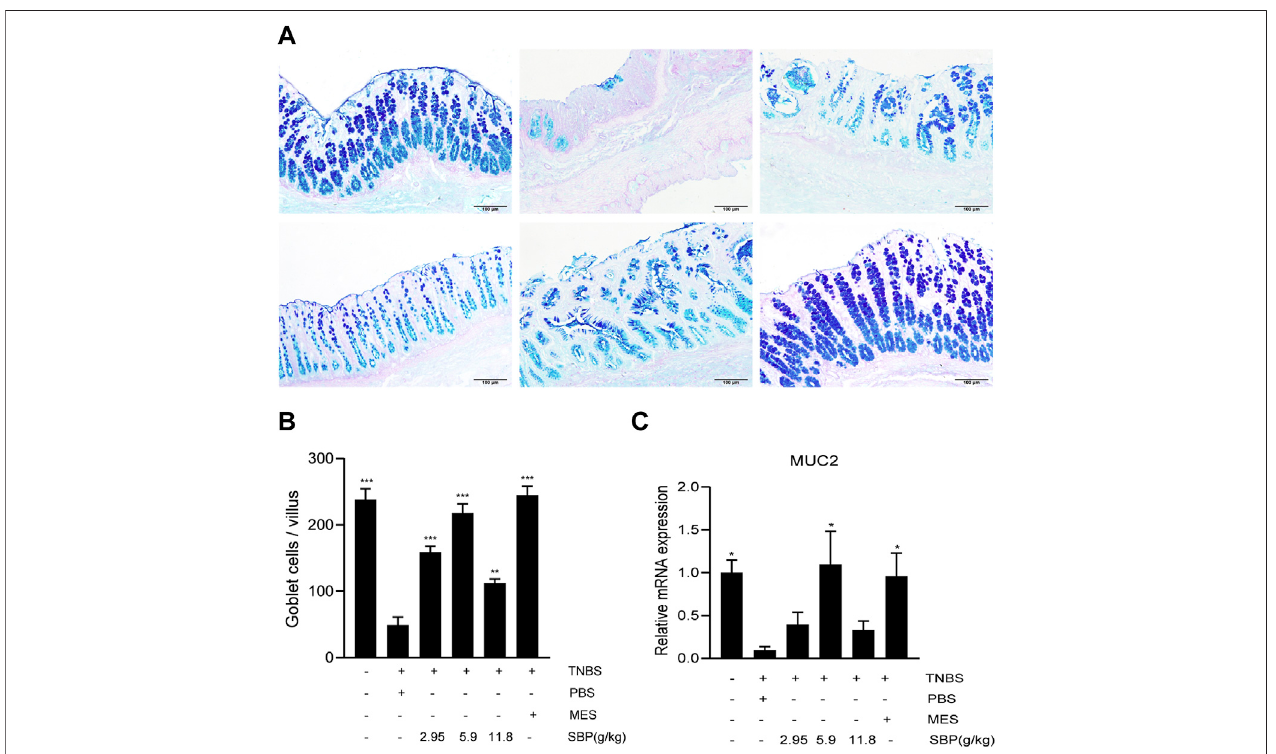
FIGURE5| SBP restructuredgobletcellsandrepairedthefunctionsofdisruption ofthemucin barrier . (A) Mucin andgobletcellsusingAB-PASstaining. Scale bar = 100 µM. (B) Number of goblet cells. (C) mRNA expression level of MUC2 in the colon tissue was determined by qPCR. vs. TNBS + PBS group, n = 5 rats/ group. Data shown as means ± SEM. * p < 0.05, ** p < 0.01, *** p < 0.001.